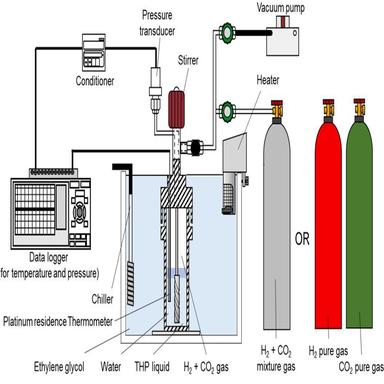
Schematic illustration of the experimental apparatus used in this study.